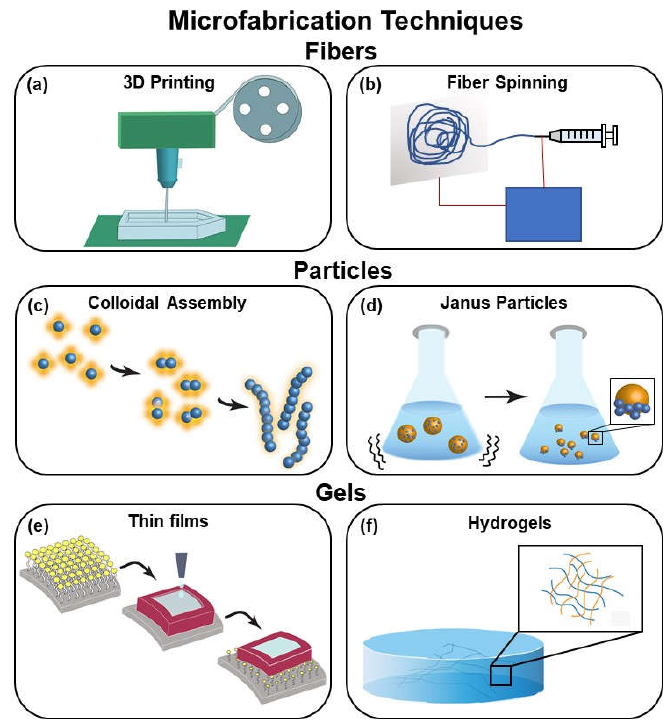
Figure 5. Summary of microfabrication techniques including ( a ) 3D printing, ( b ) fiber spinning, ( c ) colloidal assembly, ( d ) Janus particles, ( e ) thin films, and ( f ) hydrogels.